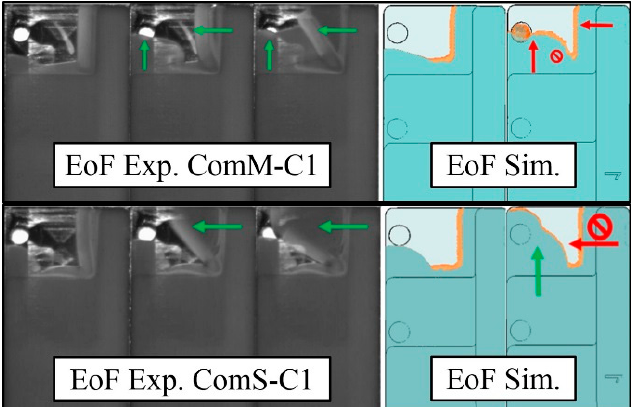
Figure 11. Comparison of the experimental and simulated flow fronts in experiments ComM-C1 and ComS-C1 in the final moments of the filling.